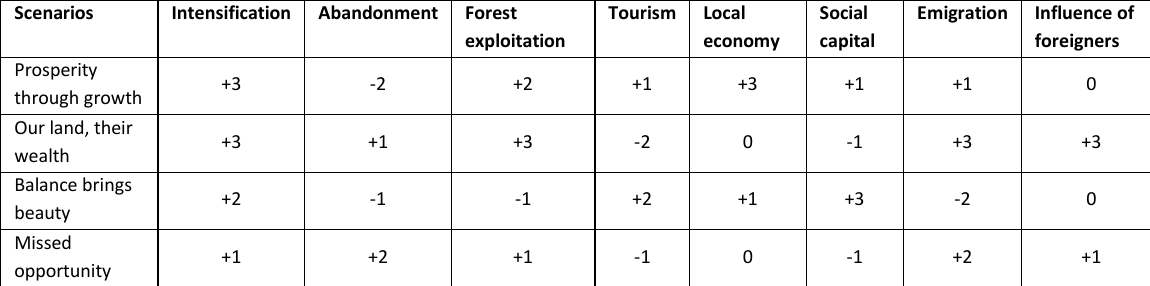
Appendix Table A1.3. Scores describing how trends in variables of regional system dynamics are expected to change under the four different scenarios. Values are based on the relative changes as described in the scenario narratives. Possible changes are: strong dampening